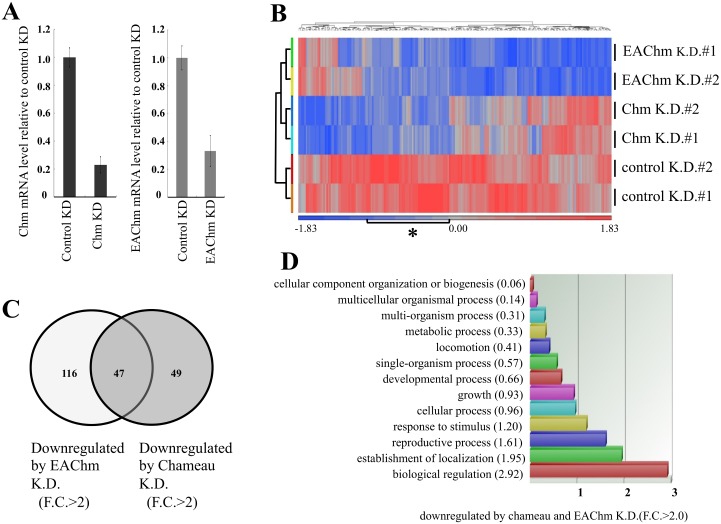
Chameau and EAChm target genes overlap in vivo.A) Evaluation of RNA interference by RT-qPCR. RT-qPCR was performed to document the efficiency of Chameau and EAChm KD. Expression level was normalized with reference to GAPDH. Error bars represent mean ±SD, n = 3. B) Heat map of downregulated genes in control knockdown (KD), Chameau KD and EAChm KD S2 cells. Blue and red indicate down and up regulated genes, respectively. The asterisk indicates the genes commonly downregulated by both Chameau and EAChm KD. C) Venn diagram of genes downregulated more than 2 fold (p-value < 0.05) by Chameau KD or EAChm KD compered to control KD. This diagram shows 47 genes that were overlapping as both Chameau and EAChm target genes. D) Gene ontology (GO) classification analysis of 47 genes common to both Chameau and EAChm KD at Fig 4C.